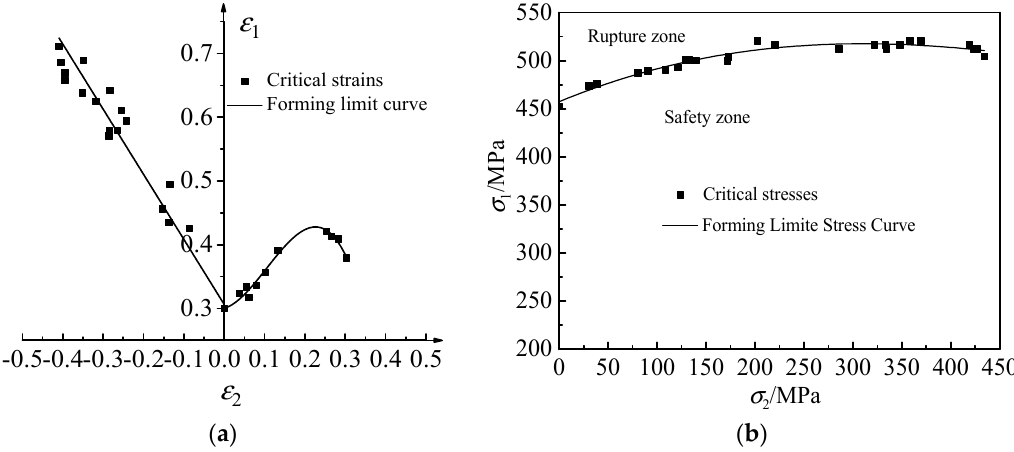
Figure 9. Forming limit diagram (FLD) and forming limit stress diagram (FLSD) of TA1 sheet ( a ) FLD; ( b )